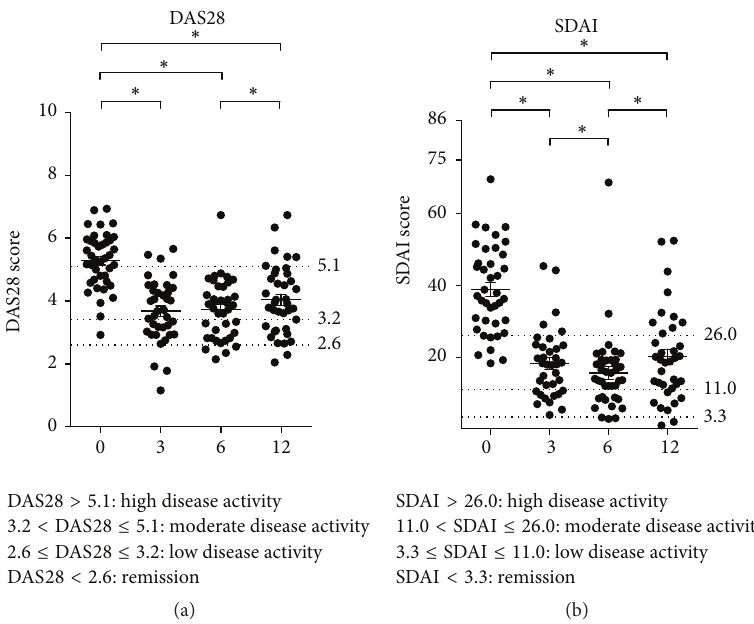
Figure 1: DAS28 and SDAI scores. Scatter dot plots where each dot represents one individual patient. (a) SDAI and (b) DAS28 score distribution during the study period. The 𝑦 -axes represent the disease activity score. The horizontal lines in the dot plot indicated the mean value. The dotted horizontal lines indicate borders between categories of disease activity: (i) high; (ii) moderate; (iii) low; and (iv) patients who are considered in remission. The 𝑥 -axis is the four assessment time points indicated as 0, 3, 6, and 12 months after treatment is initiated.